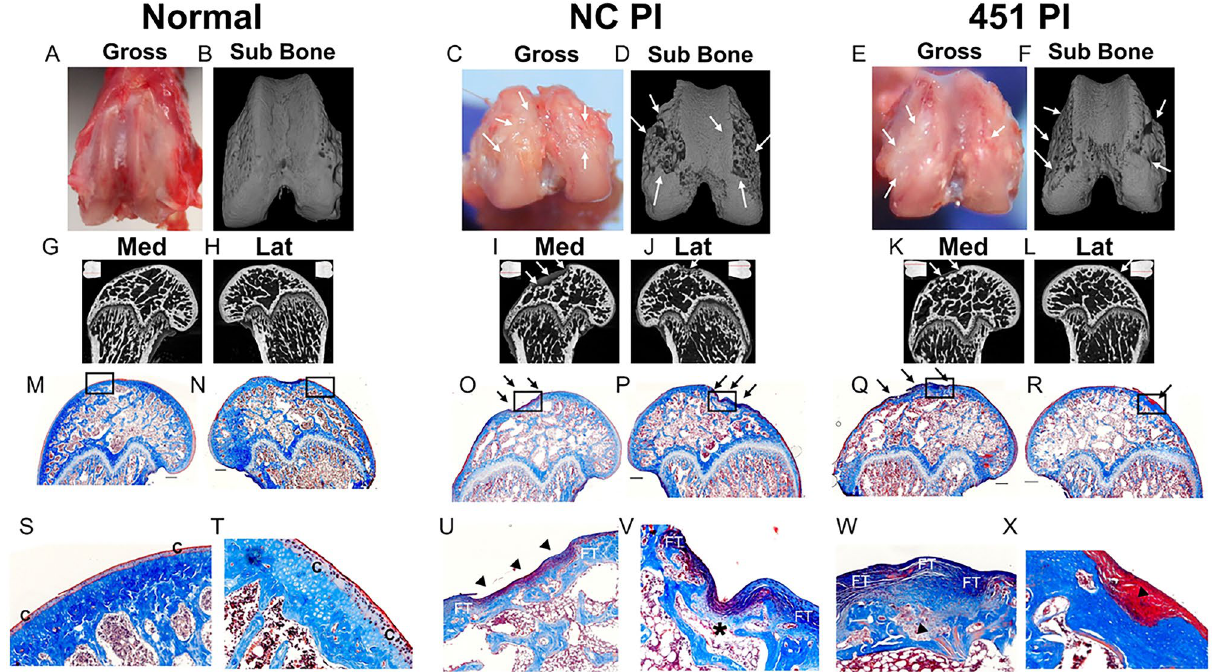
Figure 4. Gross images, micro-CT, and histology from the therapeutic cohort of the miR-451-PI study. Gross image ( A , C , E ), 3D micro-CT rendering ( B , D , F ), medial and lateral micro-CT images ( G – L ). A shadow projection of the femur is included in the top corner of each micro-CT image with a red line to indicate the location each micro-CT image is taken from within the joint ( G – L ). Masson’s trichrome histology ( M – R ) and the respective zoomed in images as depicted by the black box ( S – X ) for the normal control, NC-PI and 451-PI groups, respectively. Scale bar: 500 μm. Subchondral bone (sub bone); medial (med); lateral (lat); arrows, areas of cartilage erosion or subchondral bone remodeling; arrow heads, abnormal cartilage remodeling; C, cartilage; FT, fibrotic tissue; asterisk,